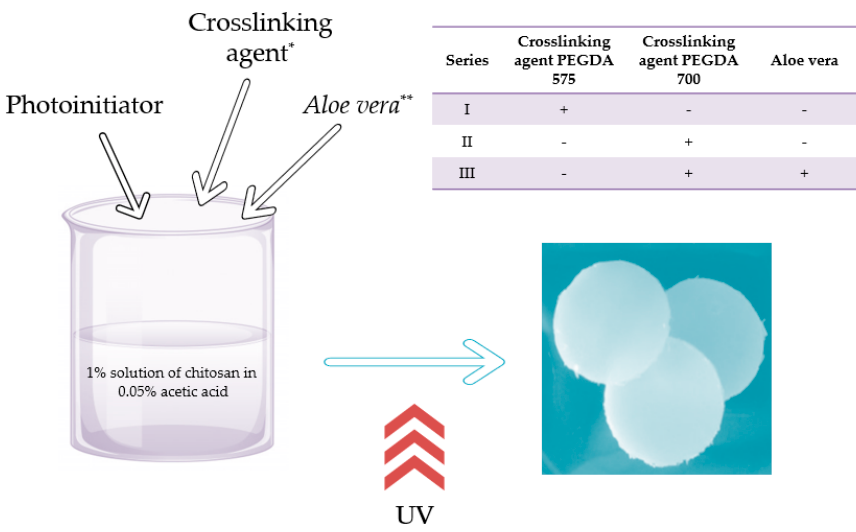
Figure 1. The scheme of the hydrogels’ preparation (*: PEGDA 575 or PEGDA 700 crosslinker; **: Aloe vera addition in the case of series III).